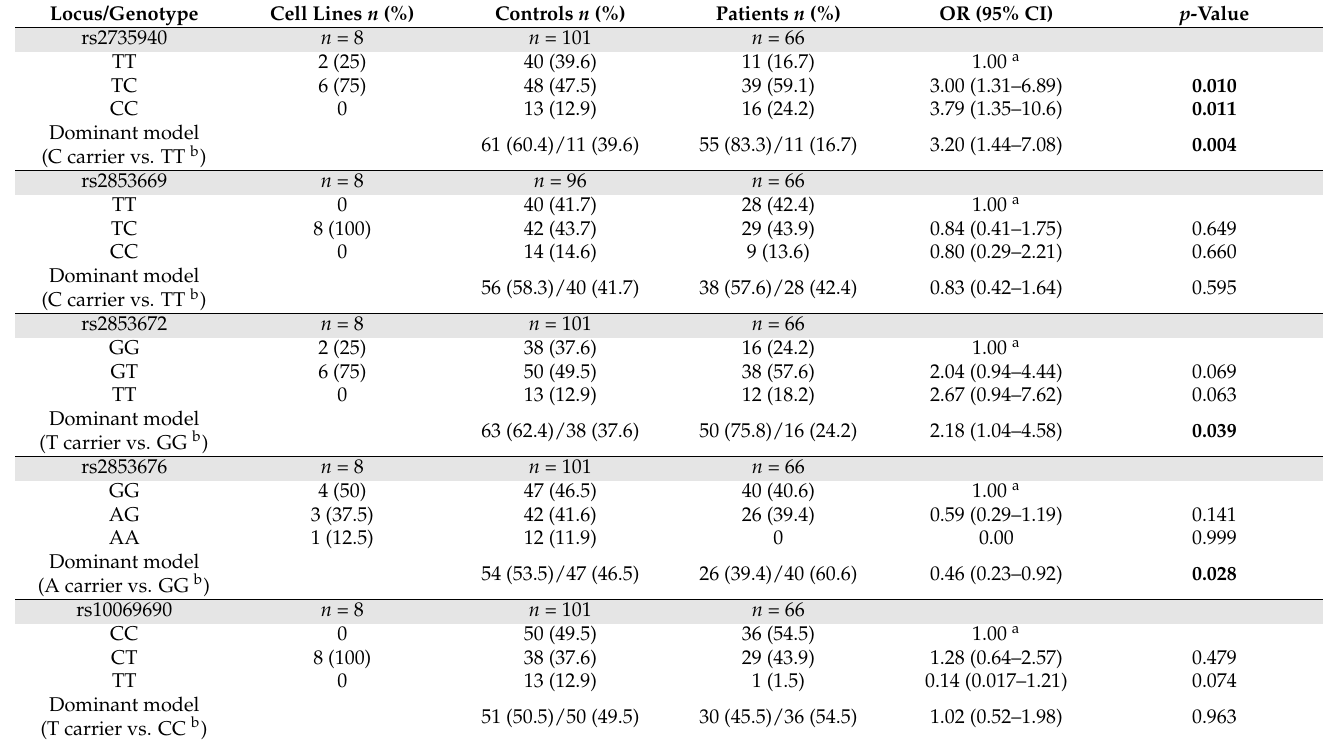
Table 1. Genotypic frequencies of rs10069690 C > T, rs2853676 G > A, rs2853672 G > T, rs2853669 T > C and rs2735940 T > C hTERT polymorphisms in CTCL cell lines, CTCL patients, and healthy